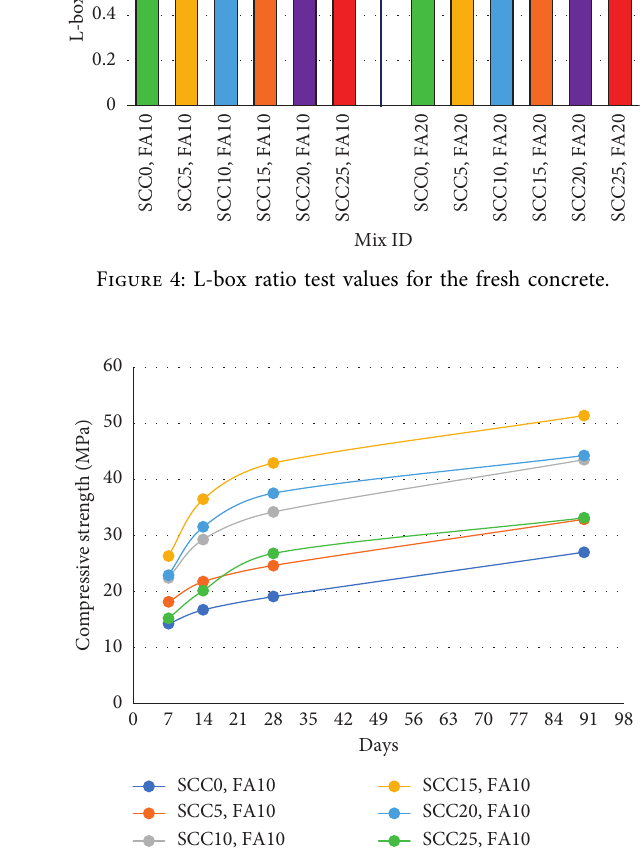
Figure 5: Compressive strength test results for concrete mixes with 10% replacement of fly